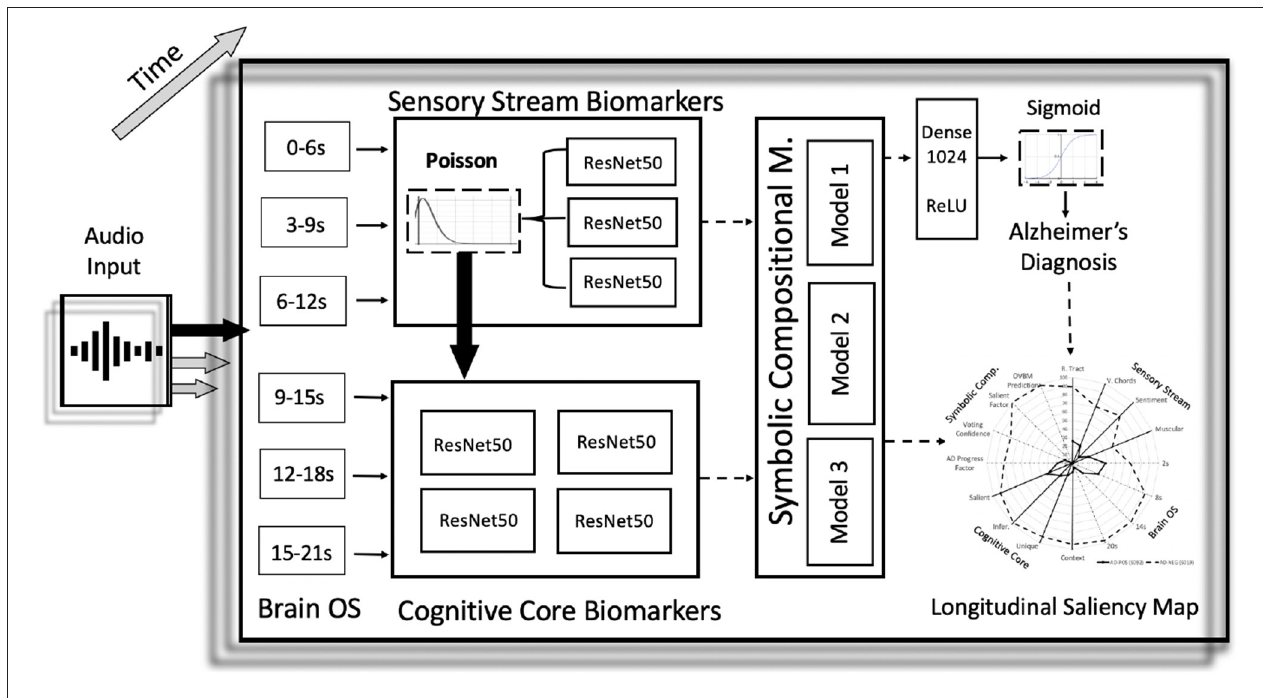
FIGURE 2 | OVBM GNN architecture at a given Brain OS